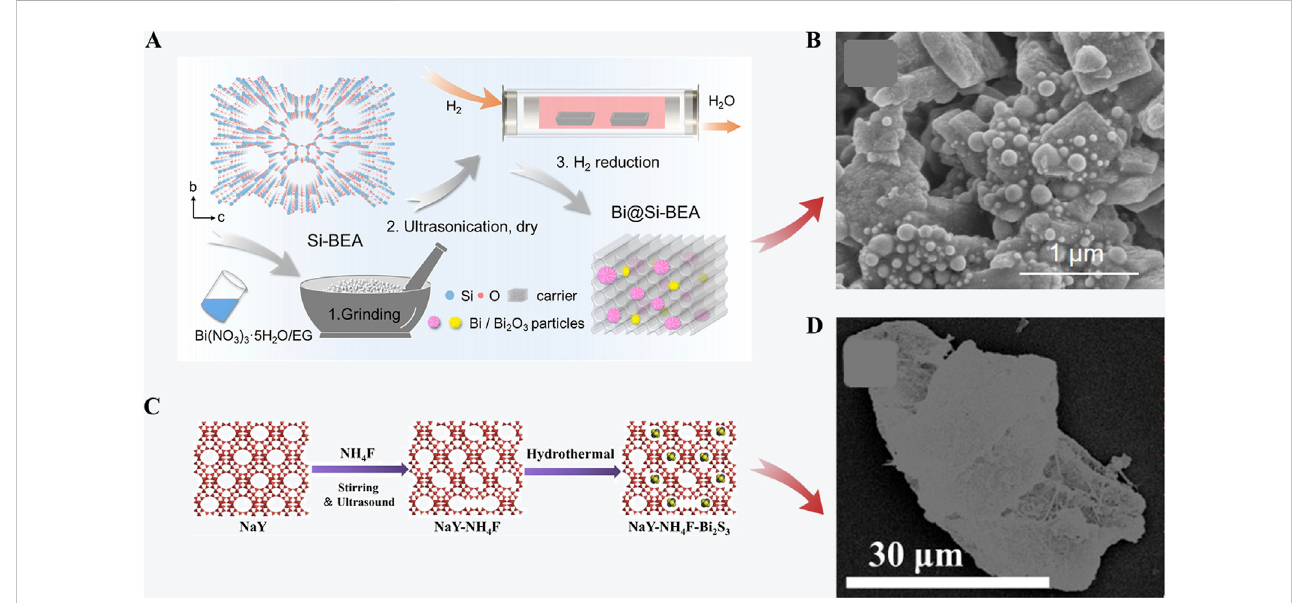
FIGURE 2 (A) Preparation of Bi@Si-BEA; (B) SEM image of Bi@Si-BEA (Tian et al., 2022); (C) Preparation of NaY-NH 4 F-Bi 2 S 3 ; (D) Mapping image of NaY- NH 4 F-Bi 2 S 3 (30%) (Jiang et al., 2022).